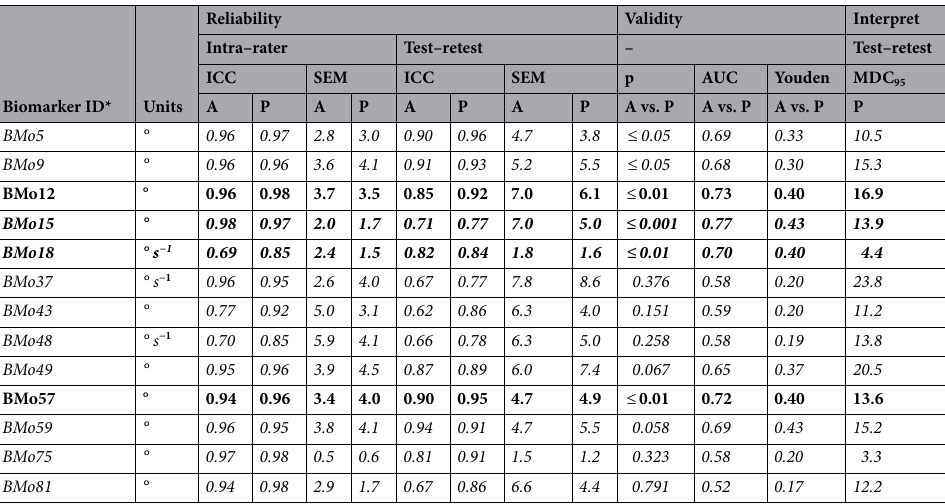
Table 4. Measurement properties of the most suitable biomarkers. *Biomarker identifiers (ID) used in the systematic review of Moissenet et al. 6 . See Table 1 for the characteristics. Biomarkers having reached at least good levels in the reliability domain are highlighted in italic, in reliability and validity in bold italic, and in reliability, validity and interpretability in bold (see Table 2 for measurement properties rating): ICC test–retest patient, SEM test–retest patient, p value, AUC, MDC test–retest patient (items used for the identification of the most suitable movement biomarkers using the Circos plot, Fig. 3). A asymptomatic participants, P patients, ICC intra-class correlation, SEM standard error of measurement, p p value (Student t-test or Mann–Whitney U-test), AUC area under curve of the ROC (Receiver Operating Characteristic) curve, Youden Youden index of the ROC curve, MDC minimal detectable change (test–retest